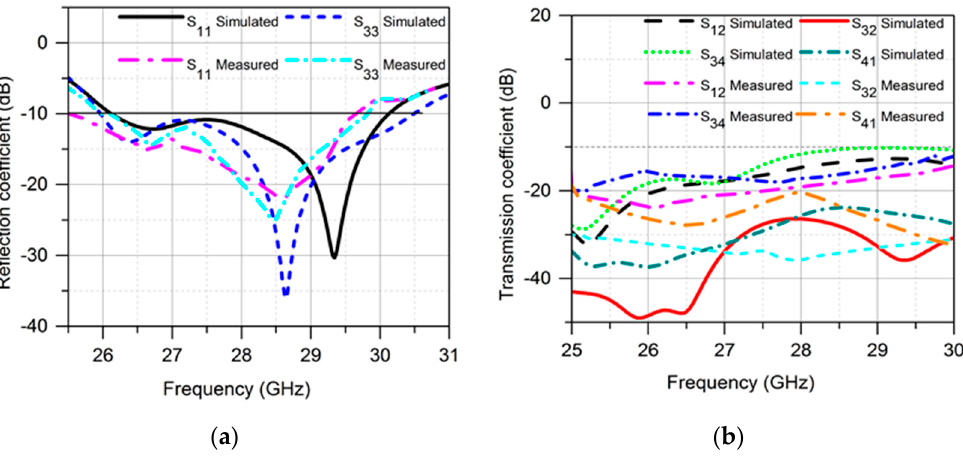
Figure 7. Measured and Simulated scattering parameter curves ( a ) Reflection coefficient curves ( b ) Transmission coefficient curves.